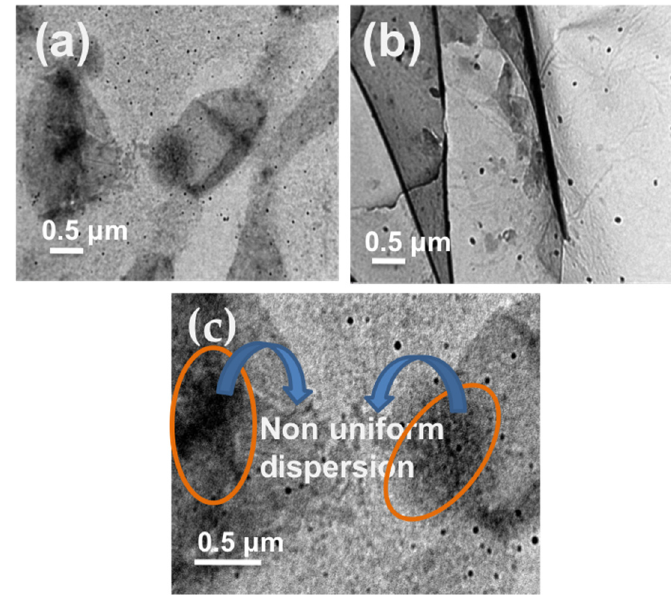
Figure 2. TEM images of ( a ) GO-Ag-PVA, ( b ) GO-Ag-PVA (IL) and ( c ) 2GO-Ag-PVA.